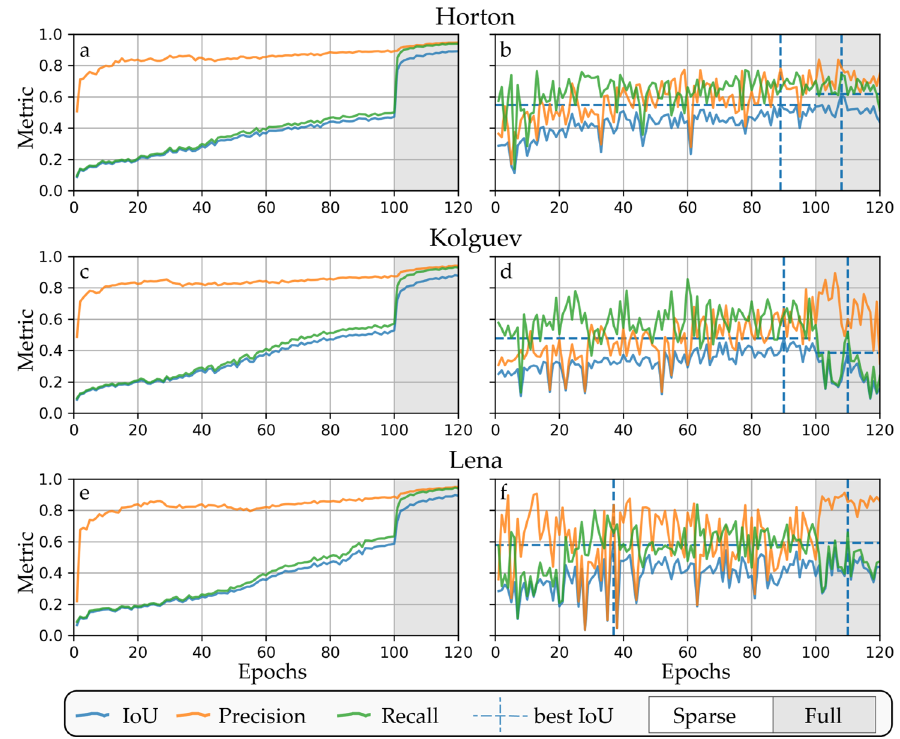
Figure 9. Training ( a , c , e ) and validation ( b , d , f ) metrics of best models for the three best regions with sparse and full training.